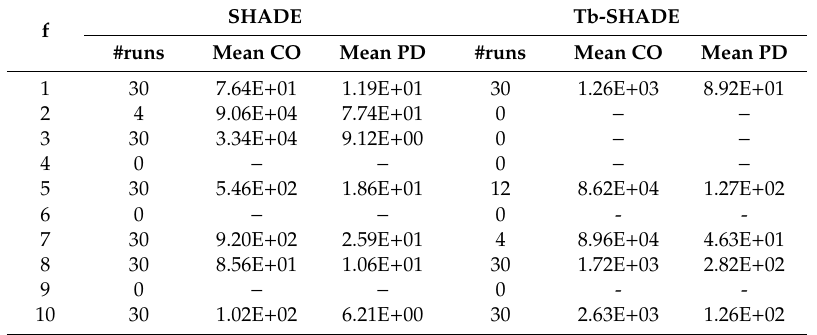
Table 26. Clustering and population diversity of SHADE and Tb-SHADE on the CEC2020 in 20 D